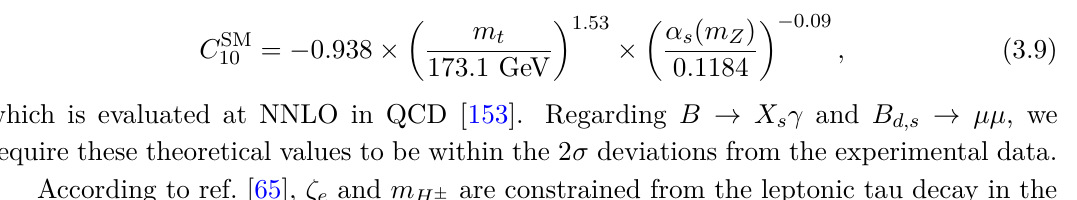
Figure 1 . The constraints on | ζ f | ( f = u, d, e ) from direct searches and flavor experiments. Input parameters are set by M = 30 GeV , λ and the heavy Higgs masses m m Φ = 400 GeV (right). Black dotted lines satisfy | ζ d | = ( m t /m b ) | ζ u | , and the gray (cyan) regions below these lines are excluded from H ± → tb , ( H ± → τν ). The green solid (dashed) lines and the magenta solid (dashed) lines are the upper bounds from H ( H ( bb ) → ττ ), respectively. In the right panel, the constraint from H 3 black dashed line. The regions above the red (orange) and blue dashdot lines are excluded by B s ( B d ) → µµ and B → X s γ ,